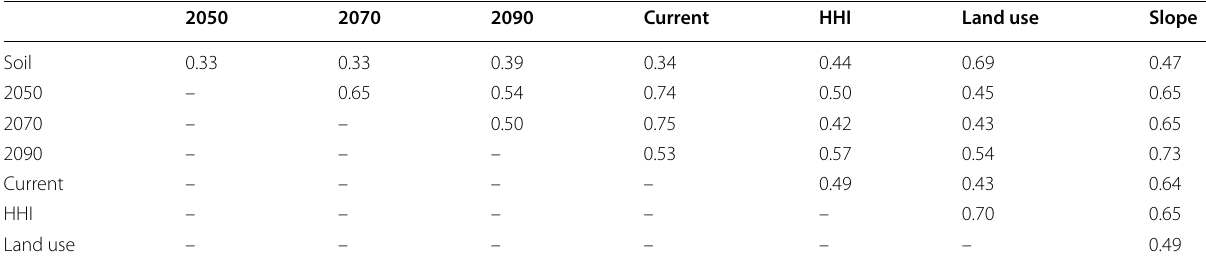
Table 9 Niche overlap Schoener’s D values between various bioclimatic and non-bioclimatic variables (individual)